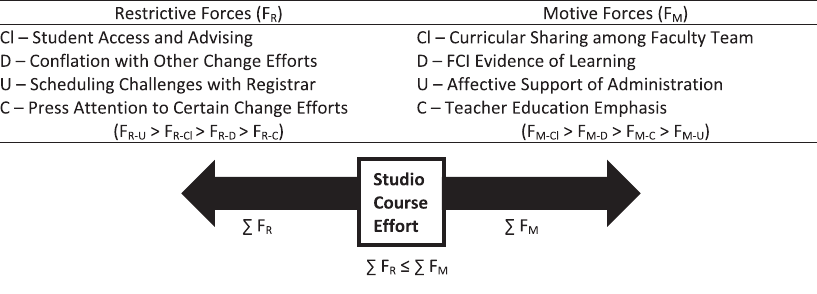
FIG. 5. Free body diagram for stage 3: Stabilization of the studio physics program (Cl—classroom; D—department; U—university;